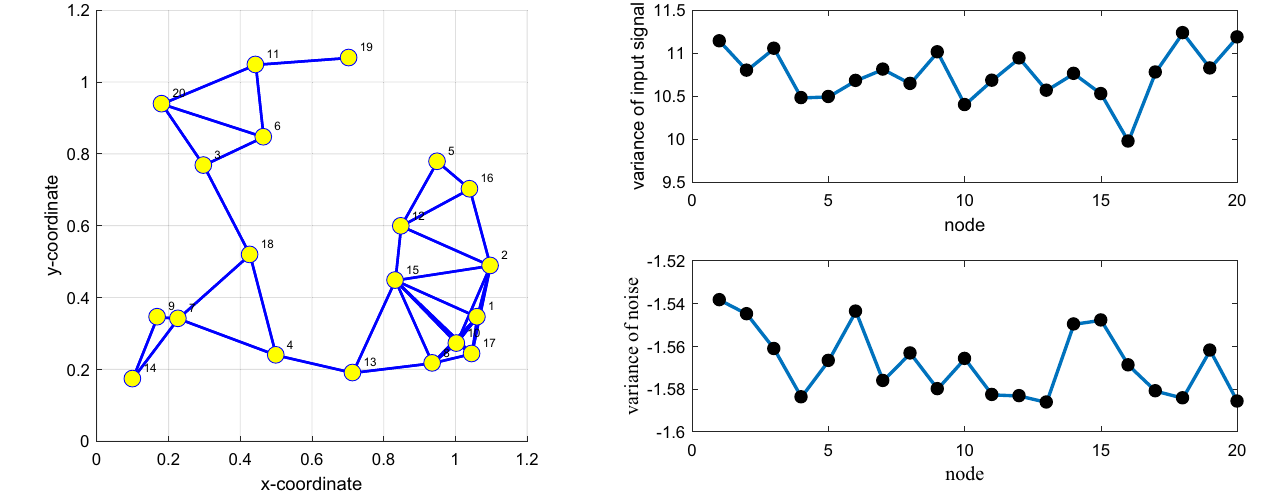
Figure 9. (Left) Random network topology to be decided by a certain radius; (Right_top) the input signals { X n ( i ) } variances of at each network node with R xx , n is a diagonal matrix with possibly different diagonal entries chosen randomly, (Right_bottom) the measurement interference variances ε n ( t ) at each network node.